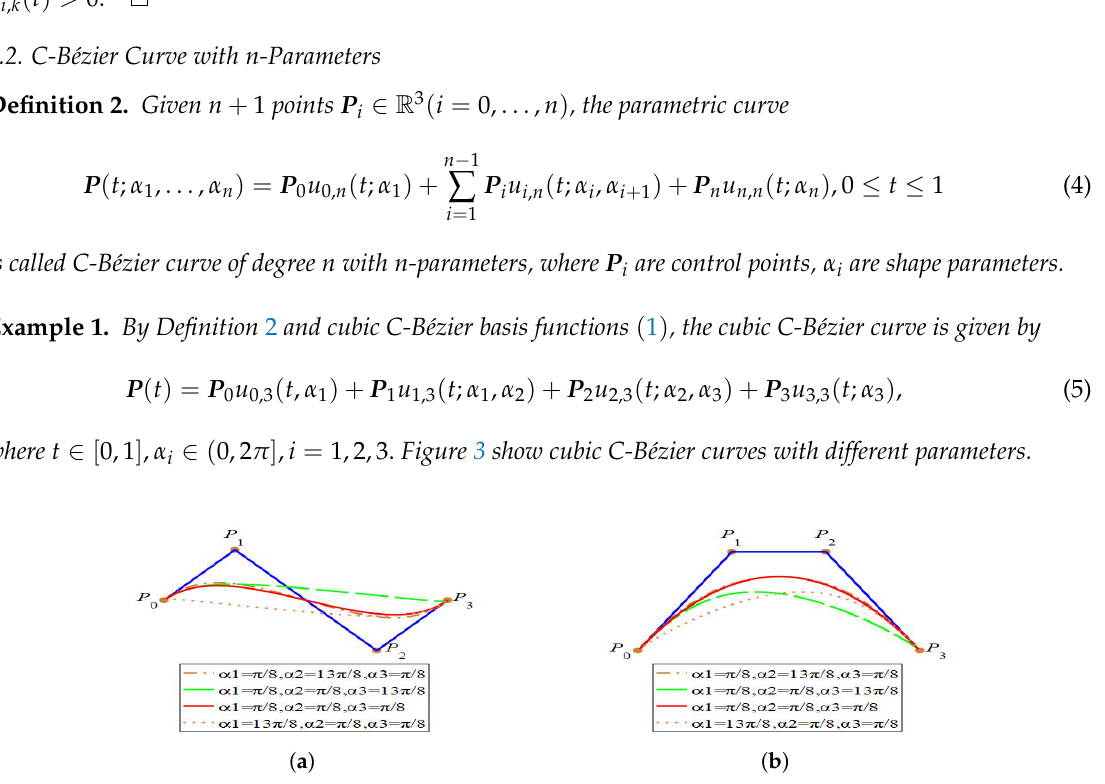
] ; α ] = [ 13 π , π , π , 13 π , π , π , π 2 8 8 8 8 8 8 8 8